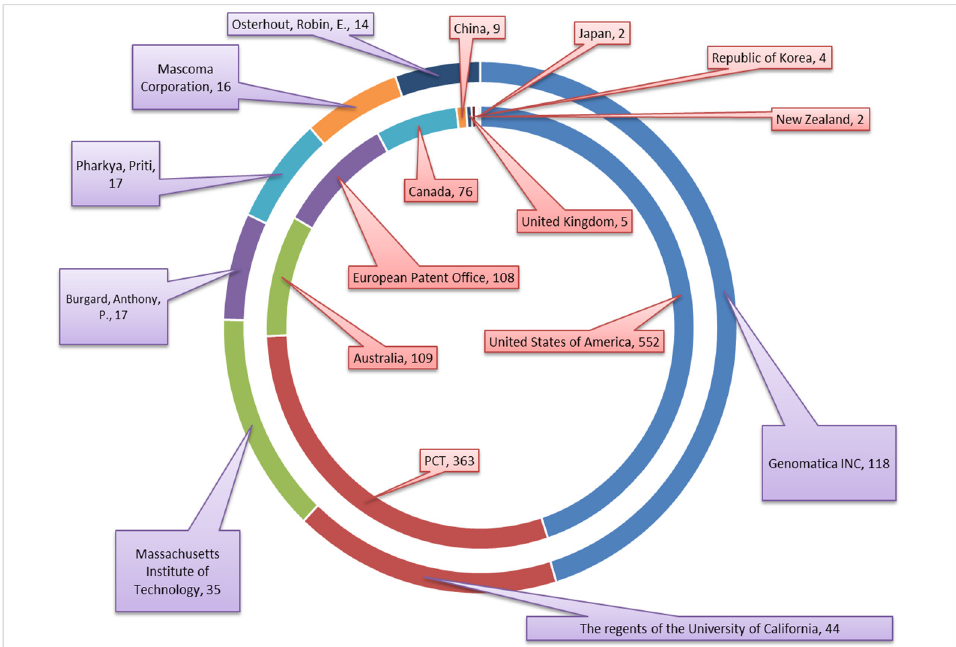
Figure 4. Patent applications by country and institution (2010–2019). Source: elaborated by the authors based on World Intellectual Property Organization (WIPO) [56].